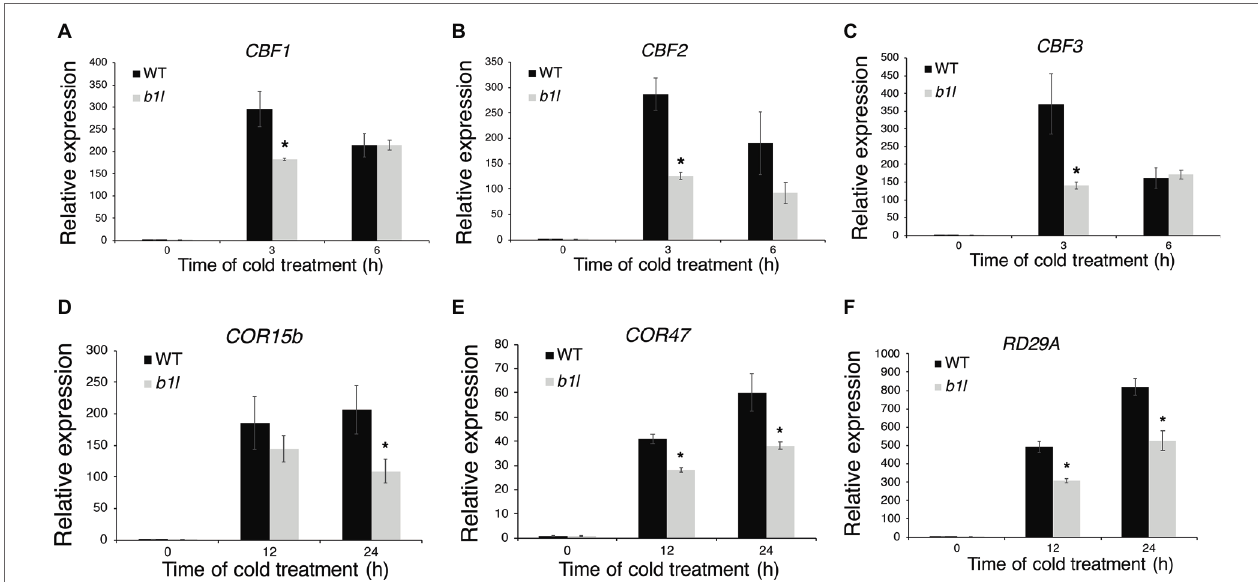
FIGURE 2 | B1L is a positive regulator of CBF pathway genes. The expression of CBF1 , CBF2 , and CBF3 (A–C) and CBF target genes COR15b , COR47 , and RD29A (D–F) in wild type and b1l seedlings was determined via qRT-PCR analyses. Total RNA was extracted from 12-day-old seedlings treated at 4°C for 0, 3, 6 h for CBF s and 0, 12, 24 h for CBF target genes and then subjected to qRT-PCR. The data are shown as means of three independent biological replicates ± SD. Asterisks indicate significant differences (* p < 0.05) from wild type.